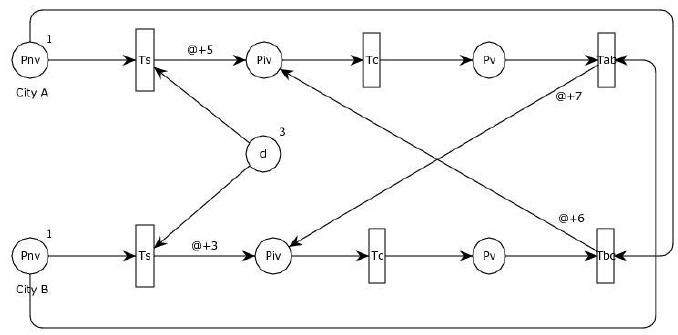
Figure 6. CPN model of a Multiple Traveling Salesman Problem.